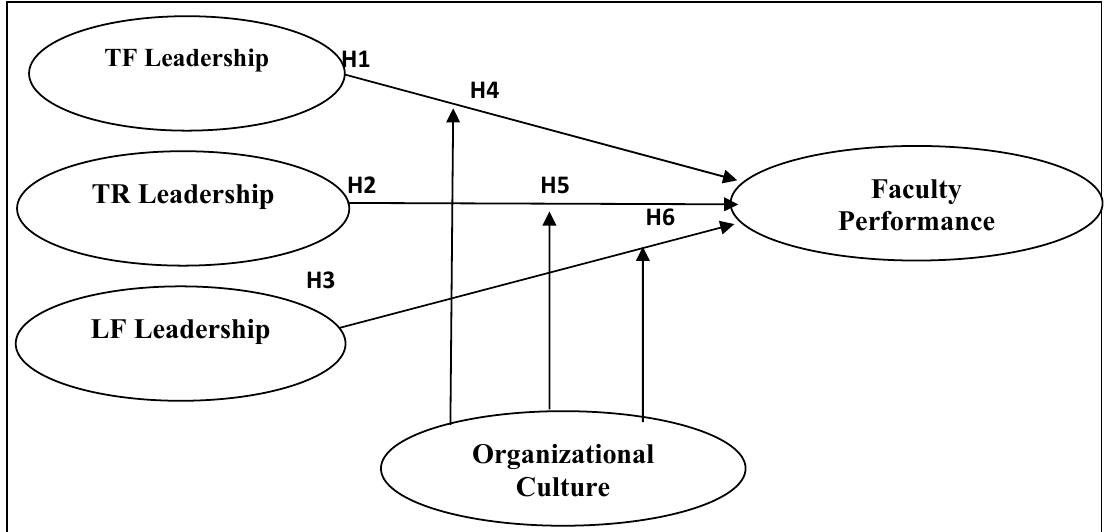
Fig 2. Hypotheses Testing